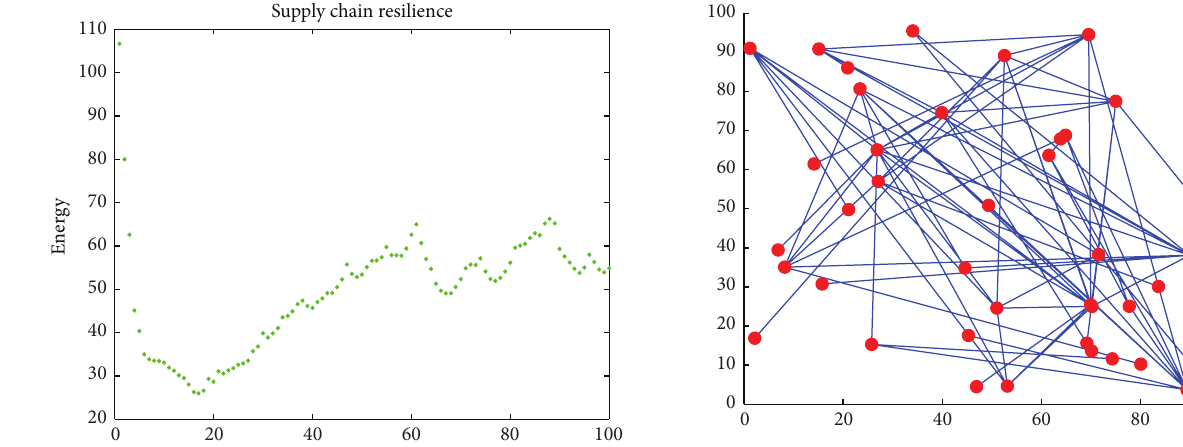
Figure 15: The supply network of chemical group.